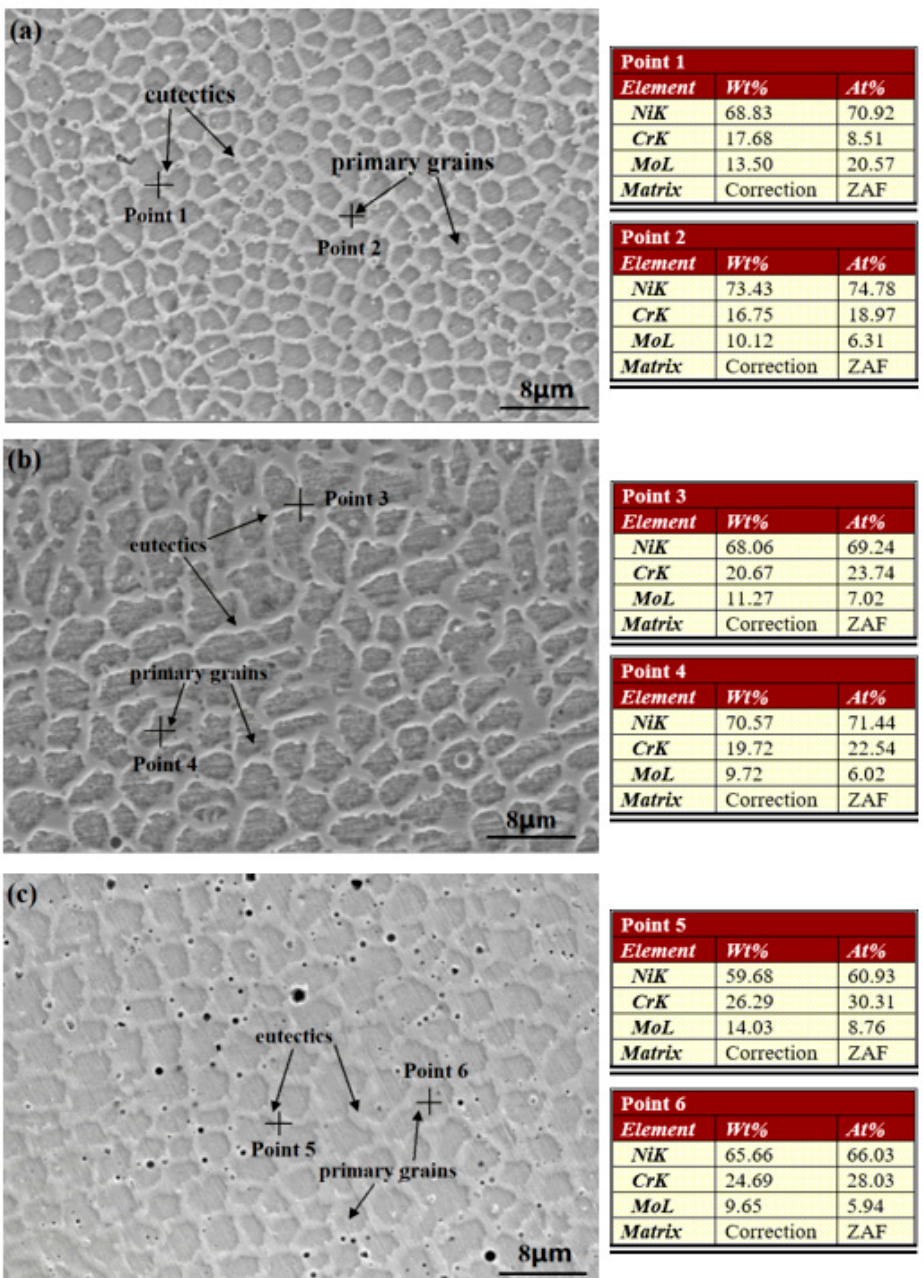
Figure 2. Surface Morphologies and elemental content analysis of laser cladding Ni-Cr-Mo alloy coatings: Cr18 ( a ), Cr22 ( b ), and Cr26 ( c ).